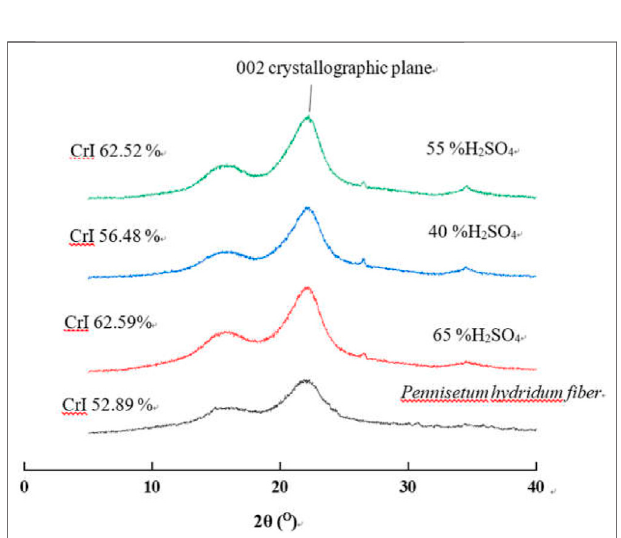
FIGURE 6 | XRD patterns of the CNC at different sulfuric acid concentrations (other conditions: RT, 120 min).